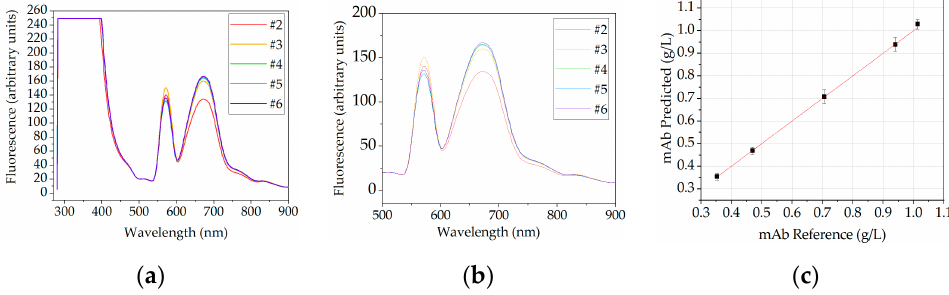
Figure 15. Fluorescence spectral data for dissolution. ( a ) raw data, ( b ) data are trimmed to the region of interest and ( c ) show the PLS regression results. The sample order is sorted from red to blue. Sample names are equal in each row and are shown in ( a , b ). Spectral data ( a ) has been previously published [6].